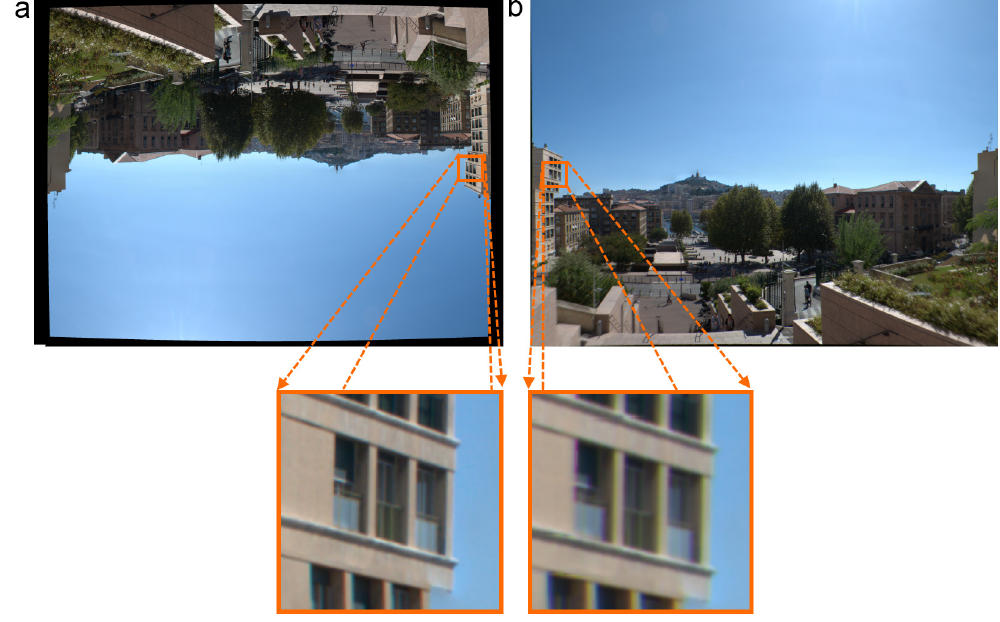
Figure 7. Simulation of the image obtained with the VR system: ( a ) pre-distorted source image; and ( b ) simulation of the projected